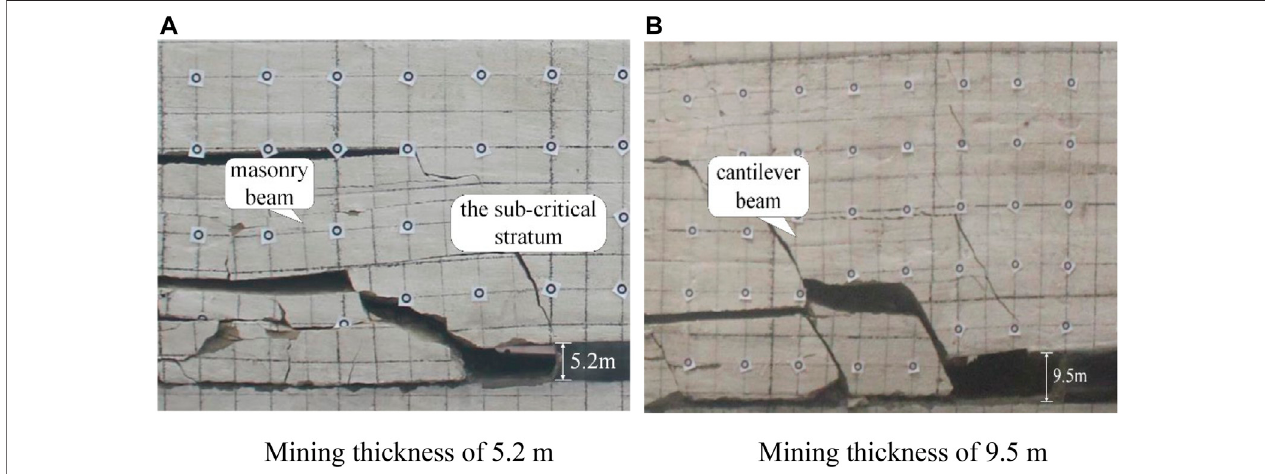
FIGURE5| Morphologytestresultsofcriticaloverlyingstrataduringthickeningcoalseamminingunderdifferentminingthicknesses. (A) Miningthicknessof5.2m; (B) Mining thickness of 9.5